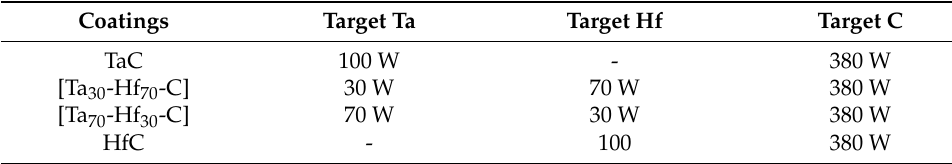
Table 2. Power applied to the TaC and HfC targets.